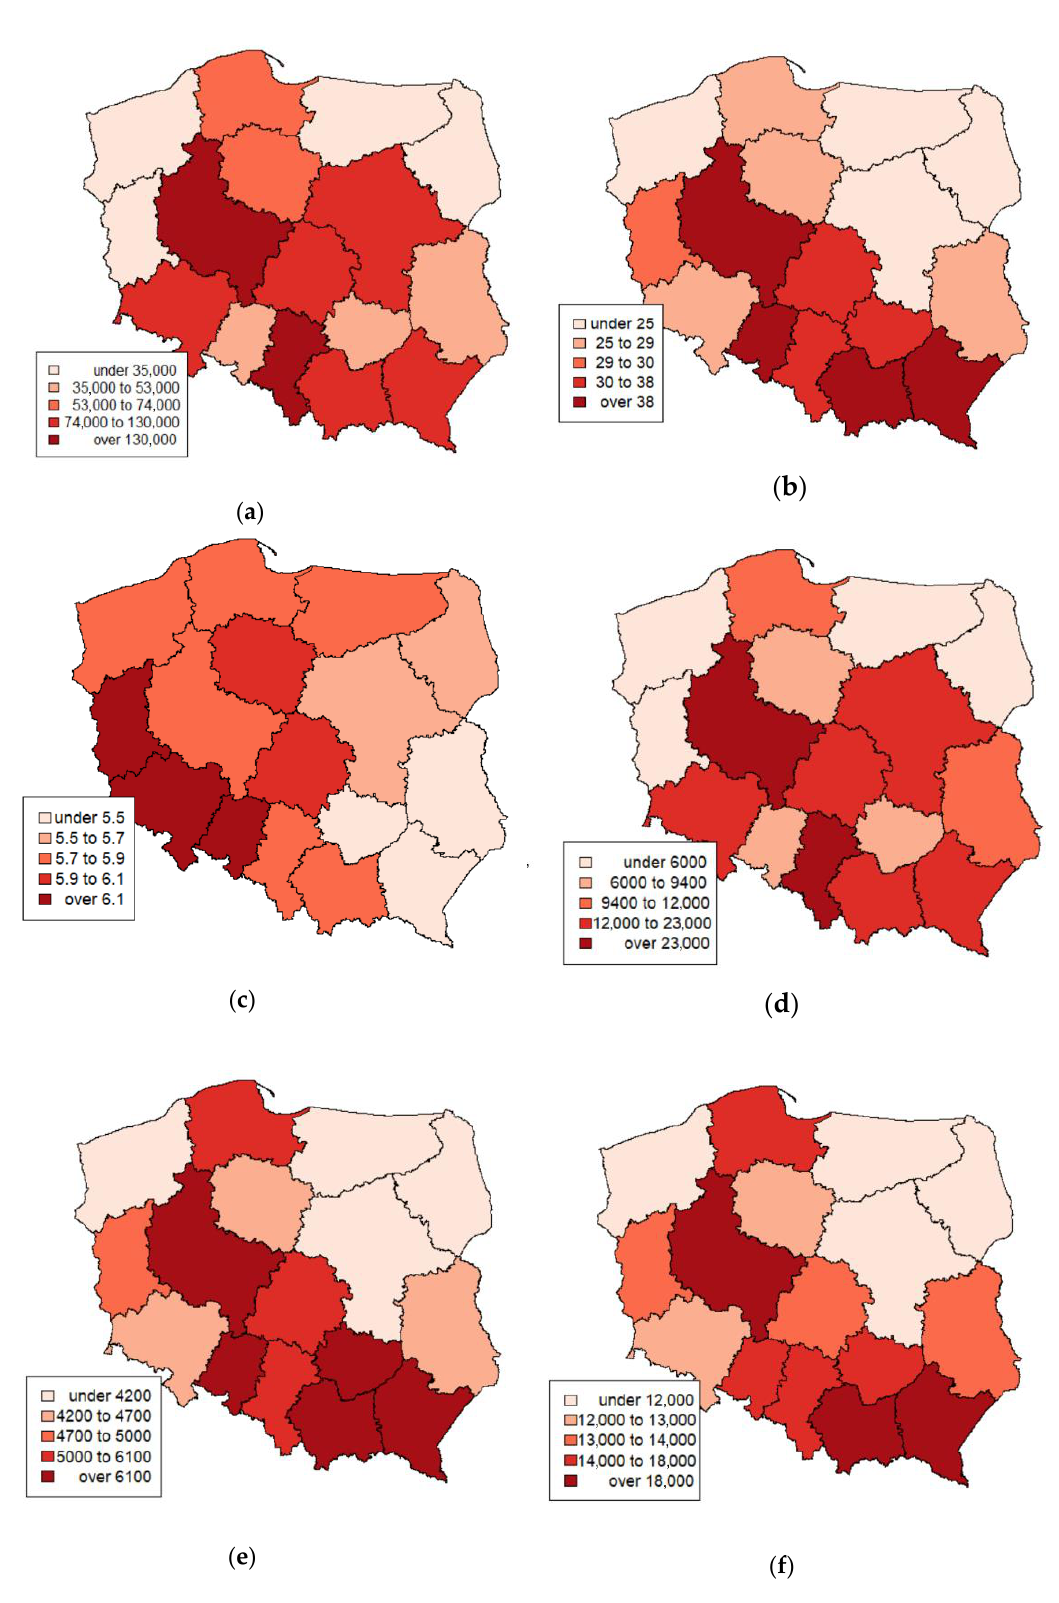
Figure 6. Spatial distribution of variables describing photovoltaic installations. ( a ) Total installed capacity by regions in kW. ( b ) Power capacity in watts per capita by regions. ( c ) Power per one installation in regions in kW. ( d ) Number of PV installations in regions. ( e ) Number of PV installations per million inhabitants. ( f ) Number of PV installations per million households.